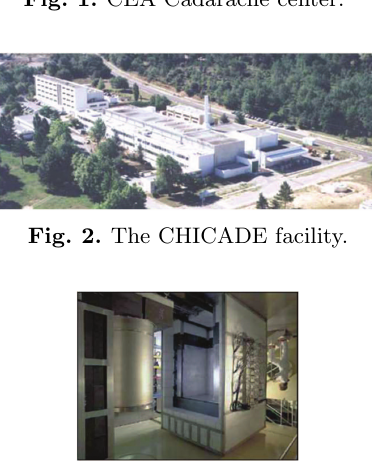
Fig. 3. A measurement casemates.